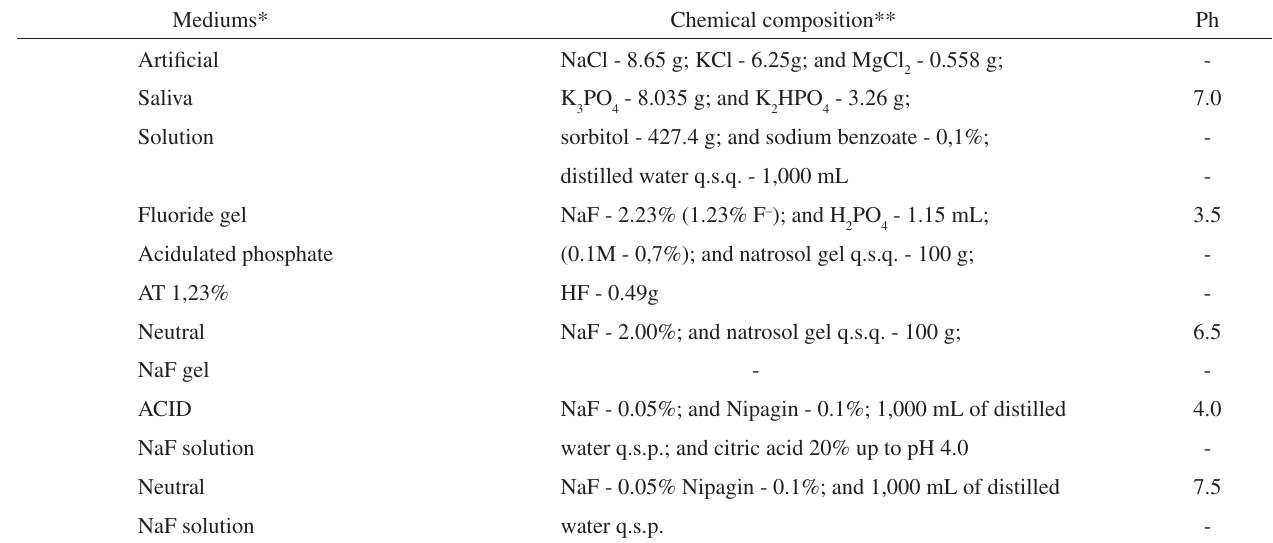
Table 1. Chemical composition and pH of the media